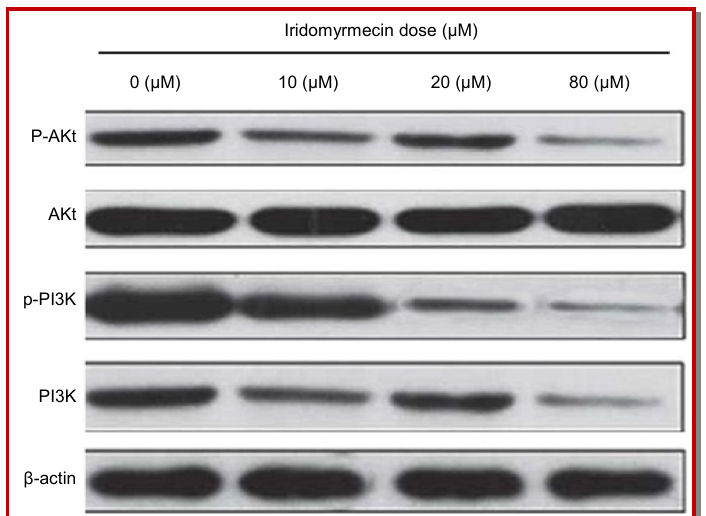
Figure 5: Iridomyrmecin leads to down-regulation of PI3K/Akt signalling pathway in human cervical cancer cells (HeLa). The changes in protein expressions were detected using Western blot. The cells were treated with 0, 10, 20 and 80 µM dose of iridomyr- mecin for 48 hours